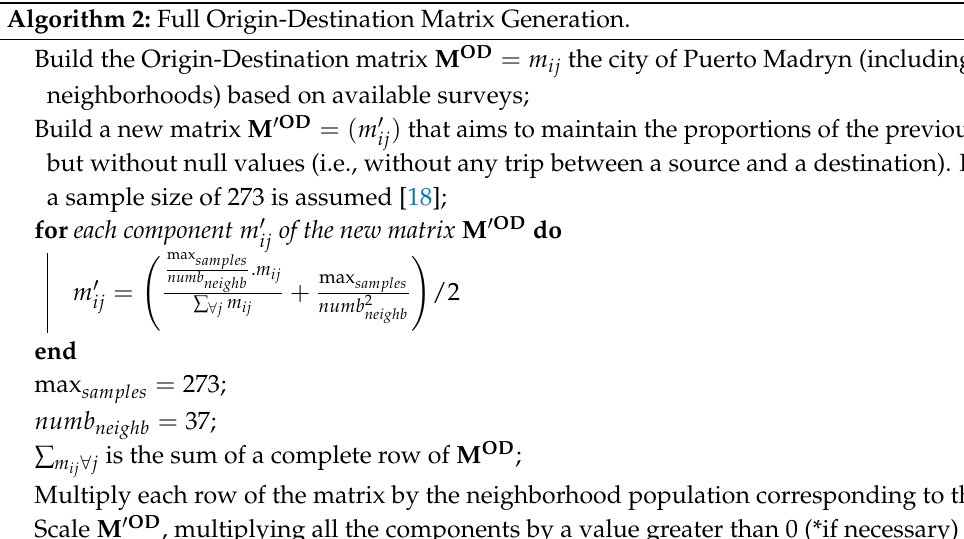
Algorithm 2: Full Origin-Destination Matrix